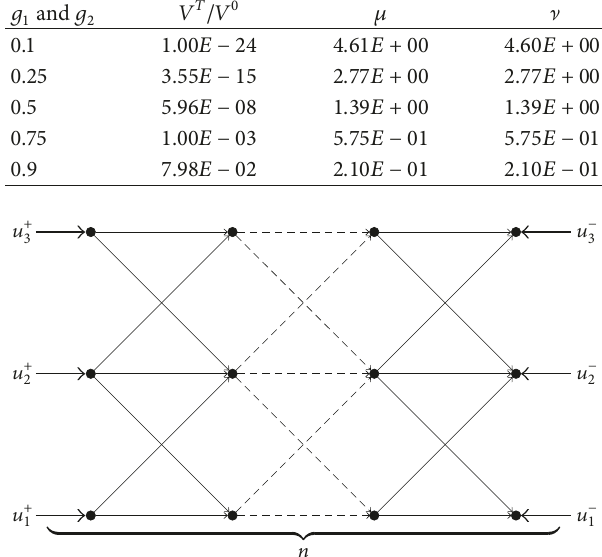
Table 1: The number of cells on each edge is 𝑁 = 1600 , with Δ𝑥 = 1/1600 . The CFL constant is equal to one; that is, Δ𝑡/Δ𝑥 = 1 .